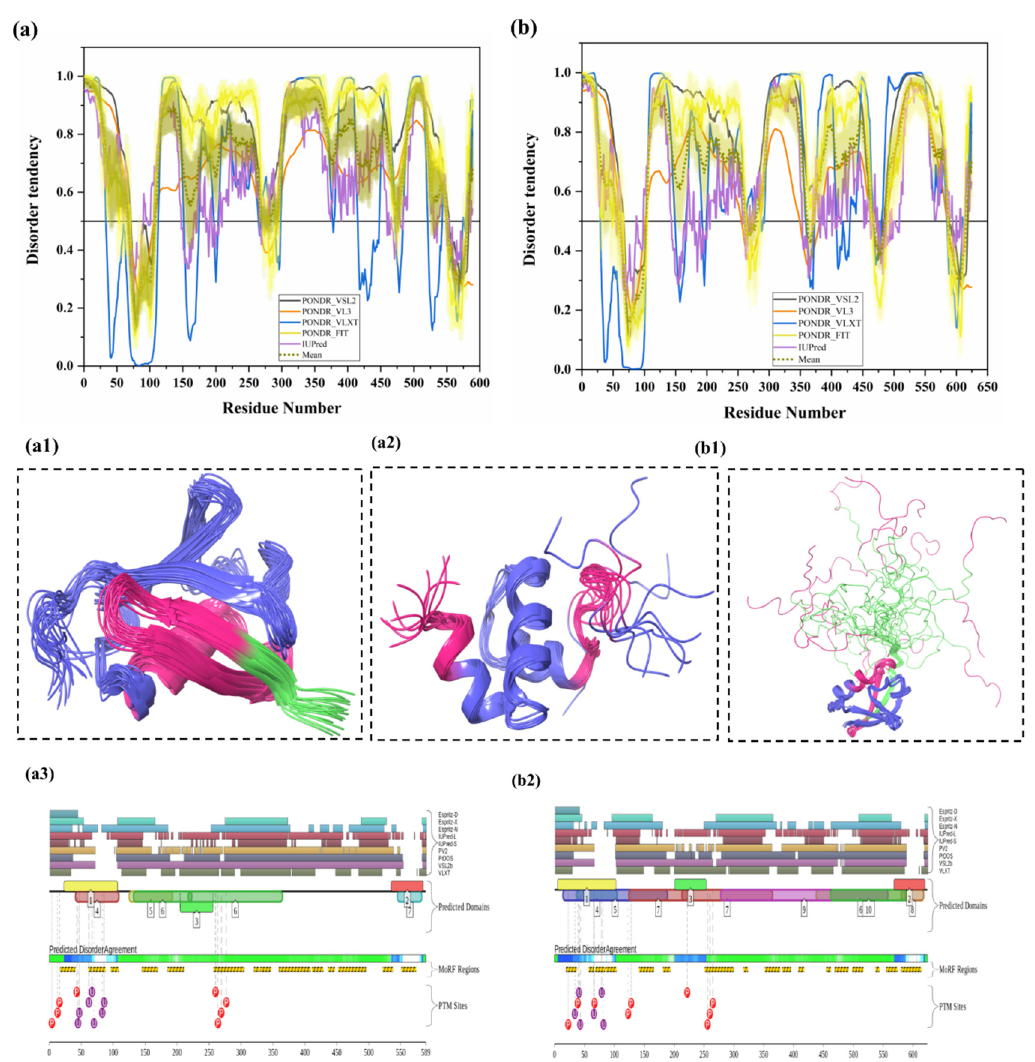
Figure 6. Intrinsic disorder predisposition and structural characterization of human UBQLN1 and UBQLN2. ( a ) Disorder profile of human UBQLN1 (UniProt ID: Q9UMX0). ( b ) Disorder profile of UBQLN2 (UniProt ID: Q9UHD9) ( a1 ) NMR solution structure of the N-terminal UBL domain (residues 34–112) of UBQLN1 (PDB ID: 2KLC). ( a2 ) NMR solution structure of the C-terminal UBA domain (residues 541–586) of UBQLN1 (PDB ID: 2JY5). ( b1 ) NMR solution structure of the N-terminal UBL domain (residues 1–103) of human UBQLN2 (PDB ID: 1J8C). In Plots ( a ) and ( b ), intrinsic disorder profiles generated by disorder predictors, such as PONDR ® VSL2, PONDR ® VL3, PONDR ® VLXT, PONDR ® FIT and IUPred, are shown by black, orange, blue, yellow, and purple curves respectively. Mean disorder profile is calculated from the average of five predictor-specific per-residue disorder profiles, represented by the olive color curve. Predicted disorder scores above 0.5 are considered disordered residues/regions. The light-olive shadow around the mean curve represents error distribution for mean. The light-yellow shadow around PONDR ® FIT curve shows error distribution for that predictor. In ( a1 , a2 , b1 ), UBQLN 1 and 2 are represented by faded blue color, and disordered residues are shown in salmon pink color. The position of the MoRF region (residues 34–39) recognized by the MoRFCHiBi_web server in UBQLN1 is represented in (PDB ID: 2KLC), and MoRF region (residues 10–38) in UBQLN2 are represented in (PDB ID: 1J8C) as MoRFs lying in the IDP region by faded green color. ( a3 , b2 ) Functional disorder profile of UBQLN1 and UBQLN2 proteins, respectively, using the D2P2 server, is shown, depicting PTM sites.